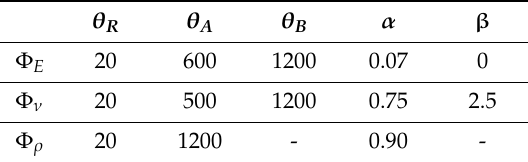
Table A1. Estimated IE peak frequencies using the simplified fire damage